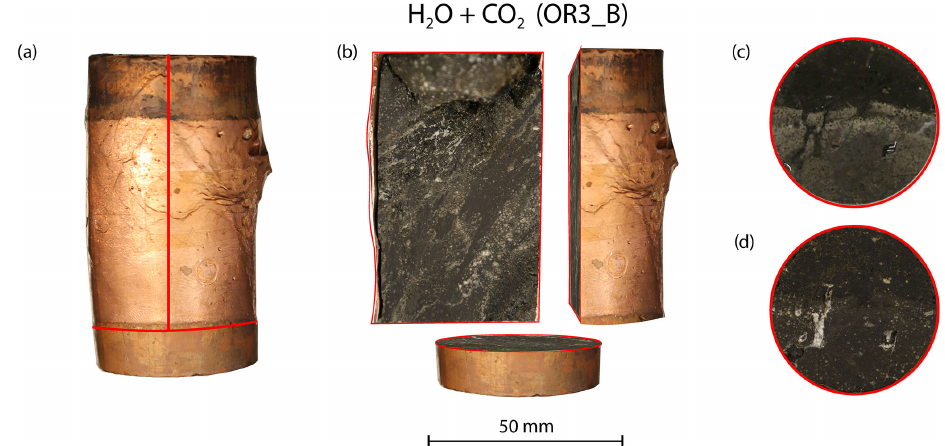
Figure 10. (a) Deformed sample from the H 2 O + CO 2 open experiment (OR3_B). (b) Cross-sectional view of the deformed sample. Top view of the sample (c) before and (d) after the